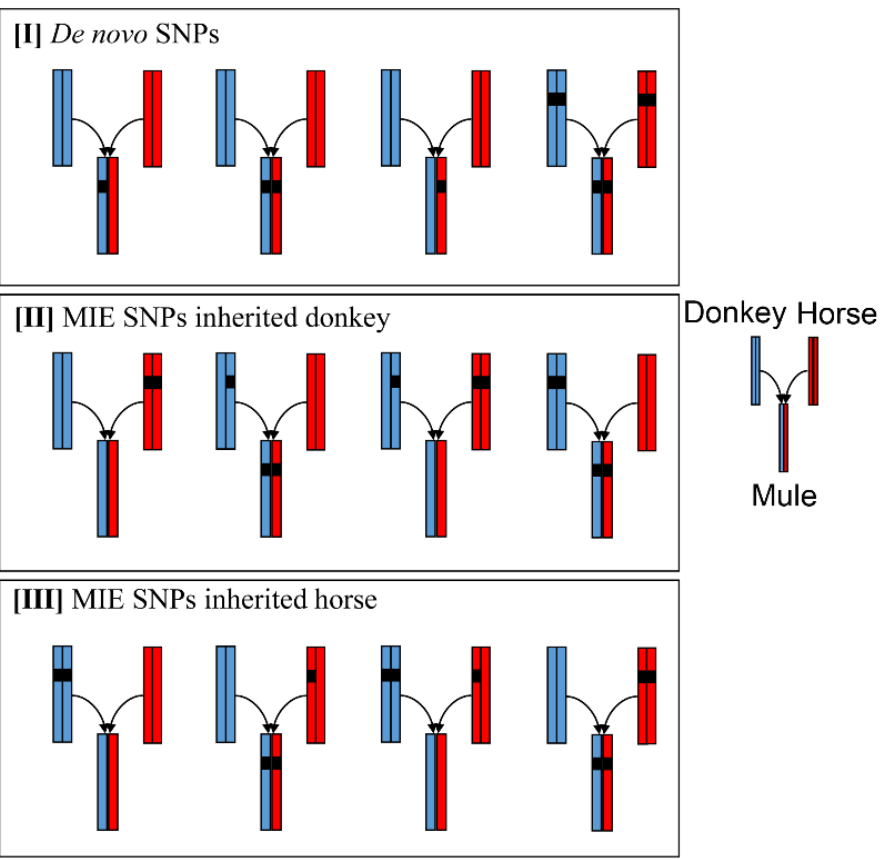
Figure 1. Analysis of non-Mendelian inheritance SNPs. Classification of non-Mendelian inheritance SNPs. When variant alleles were identified only in the mule, they were classified as [I] de novo SNPs. MIE SNPs were classified into [II] inherited from the donkey and [III] inherited from the horse.